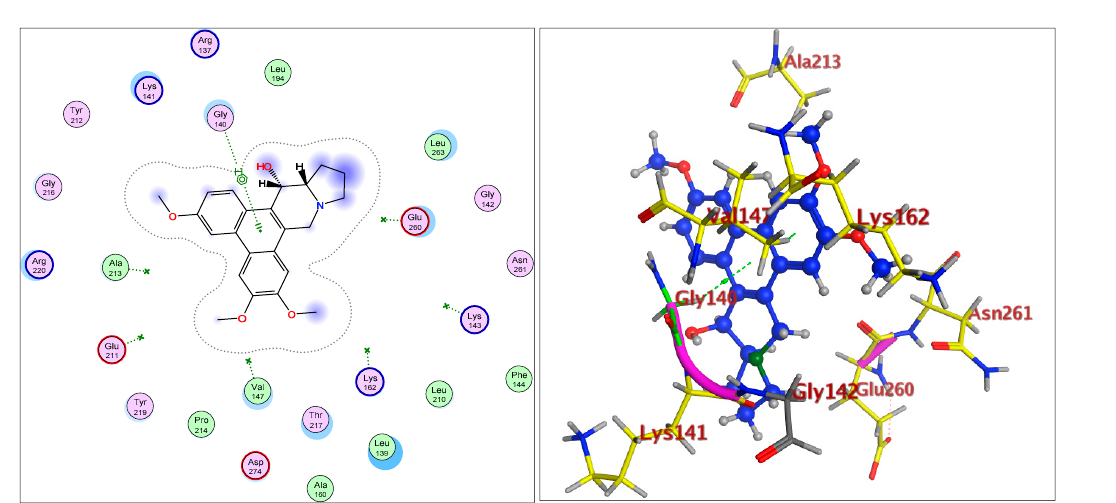
Figure 1. Overlay of compound ( 3 ) bound to the active site of ATP-binding pocket of Aurora-A.